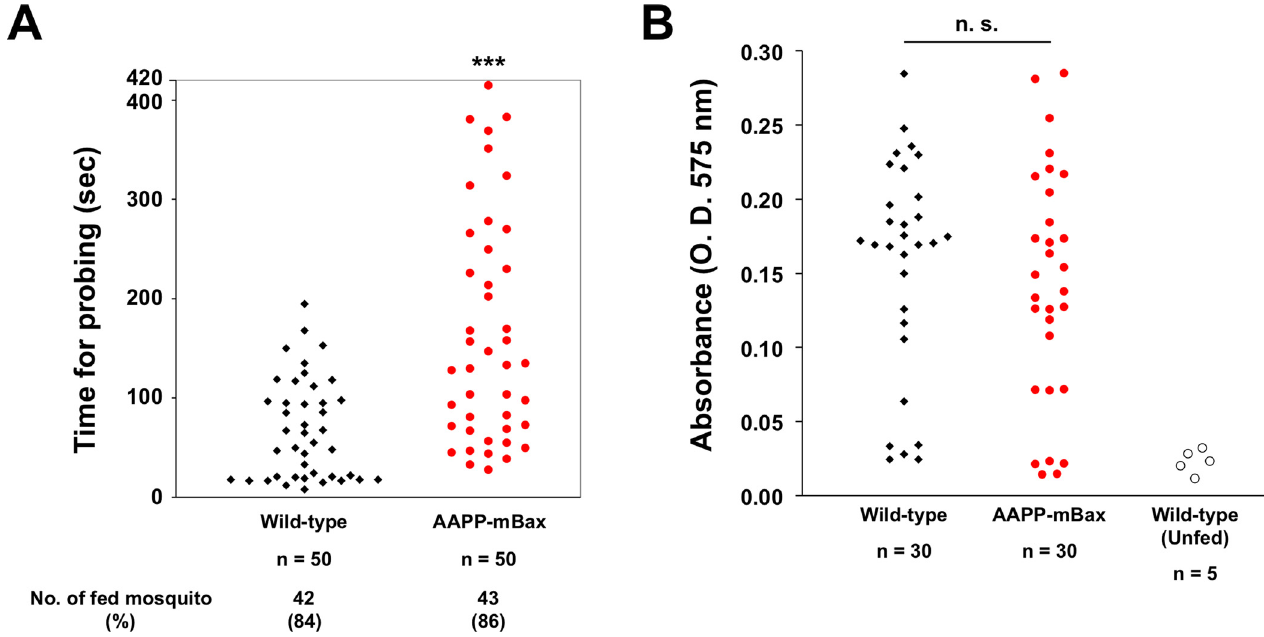
Fig 4. Analysis of the blood feeding behavior of AAPP-mBax line (line 1) mosquitoes. (A) Measurements of probing times by wild-type and AAPP-mBax mosquitoes. Each dot corresponds to one female mosquito. The probing time is defined as the time taken from the initial insertion of the mouthpart into the skin until the initial observation of the ingestion of blood in the abdomen. Probing times were significantly longer in AAPP- mBax mosquitoes than in wild-type mosquitoes. Data from two independent experiments using separate generations of mosquitoes were pooled. The number and ratio of blood-fed mosquitoes within 420 seconds are indicated below (n = 50, *** : P < 0.0001, calculated by the Mann-Whitney U test). (B) Comparison of the amount of ingested blood between wild-type and AAPP-mBax mosquitoes. The amount of ingested blood was evaluated using hemoglobin contents in the abdomens of mosquitoes allowed access to the same mice for 30 min. The hemoglobin content was represented as OD 575 units. The abdomens of unfed wild-type mosquitoes were used as the negative control. No significant difference was observed between AAPP-mBax and wild-type mosquitoes. n.s., not significant ( P = 0.3007, calculated by the Mann-Whitney U test).